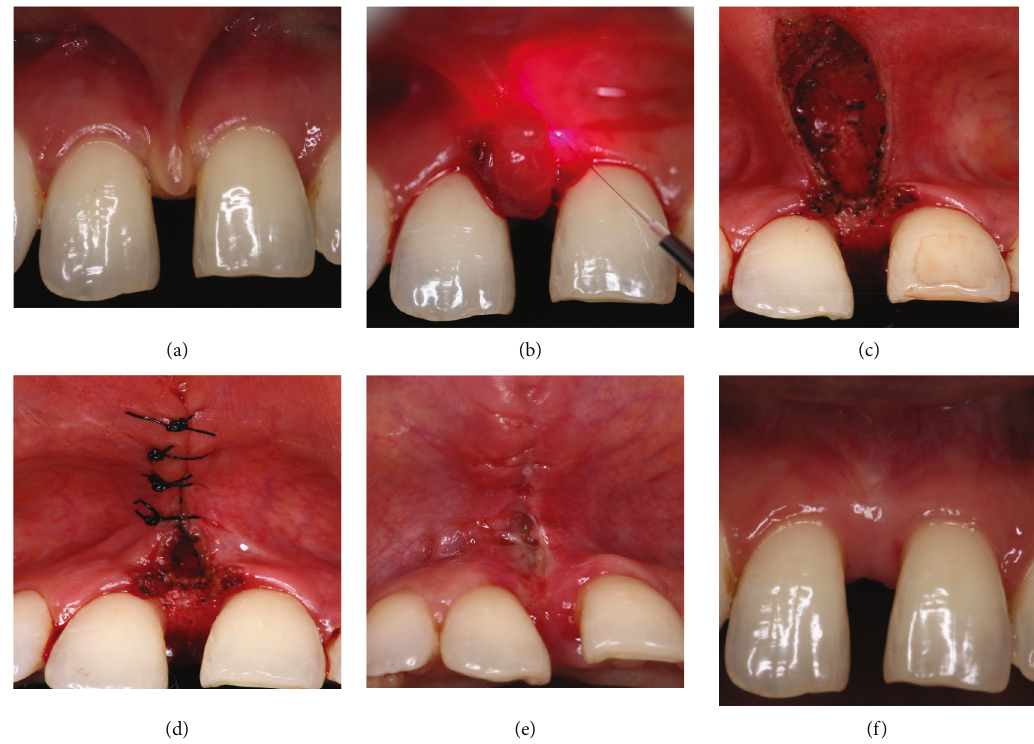
Figure 3: Clinical images of laser-treated patients on preoperative and postoperative days, 1, 7, and 30. (a) Preoperative. (b) 980nm diode laser. (c) Immediate postoperative. (d) Sutures placed. (e) 7-day postoperative. (f) 1-month